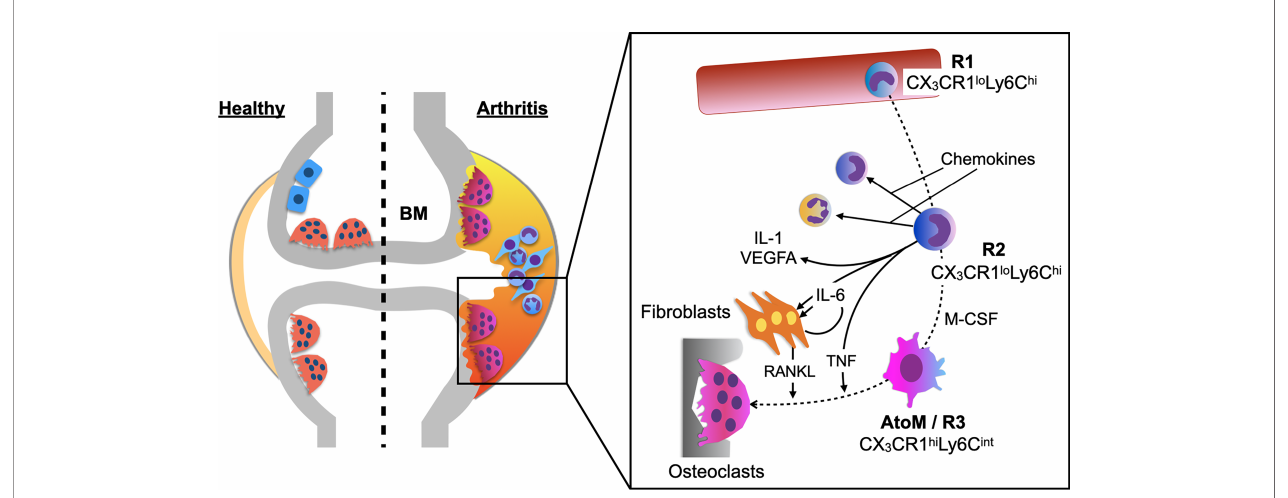
FIGURE 1 | Differentiation trajectory of pathological osteoclasts in arthritis. BM-derived CX 3 CR1 lo Ly6C hi cells (R1) ingress into the synovium (R2) and produce in fl ammatory cytokines, chemokines, and VEGFA. Abundant M-CSF in the in fl amed synovium induces maturation of some R2 cells into osteoclast precursors, arthritis-associated osteoclastogenic macrophages (AtoMs/R3 cells). When AtoMs localize adjacent to the bone surface, simultaneous stimulation with RANKL and TNF promotes osteoclast formation, leading to joint destruction in